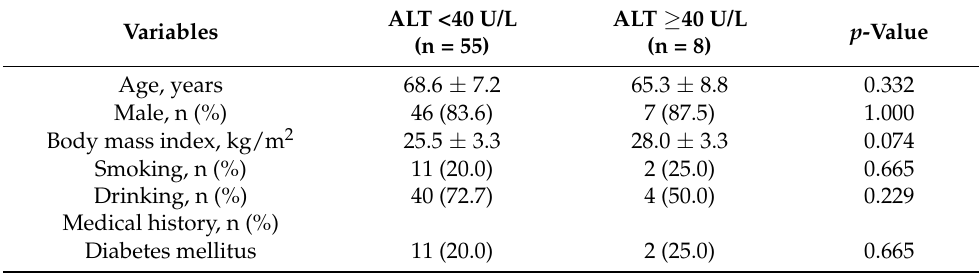
Table 3. Baseline clinical characteristics of participants with alanine aminotransferase level <40 U/L or ≥ 40